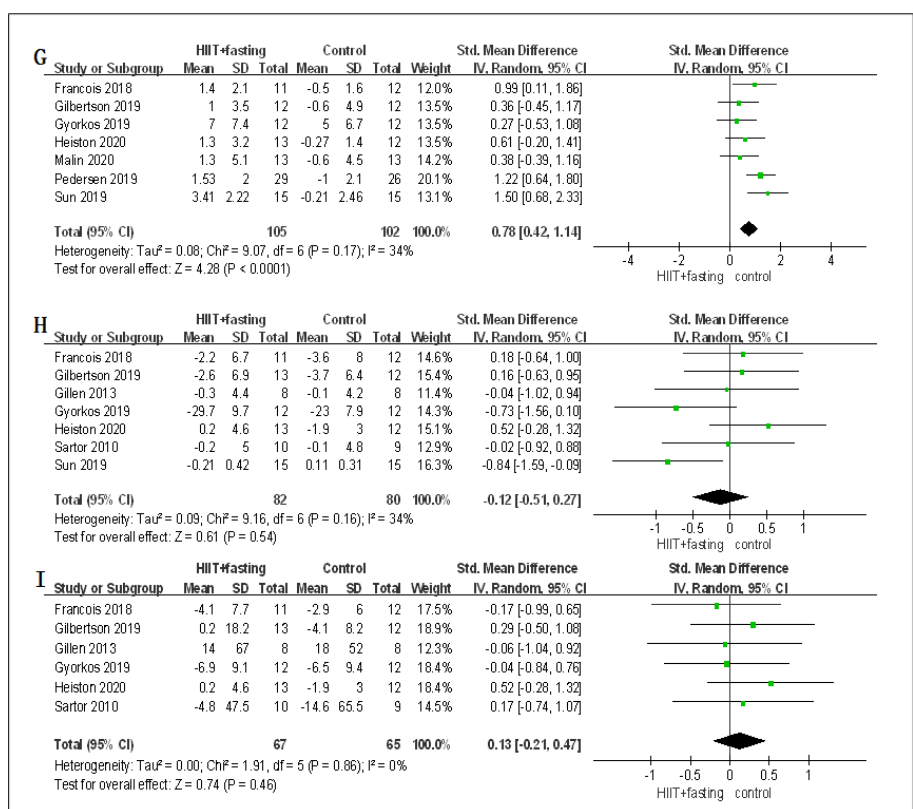
Figure 4. Forest plot for the body composition. ( A ) Forest plot for the body mass (BM); ( B ) Forest plot for the body mass index (BMI); ( C ) Forest plot for the waist circumference (WC); ( D ) Forest plot for the percent fat mass (PFM); ( E ) Forest plot for the fat mass (FM); ( F ) Forest plot for the fat-free mass (FFM); ( G ) Forest plot for changes in VO 2peak .; ( H ) Forest plot for changes in fasting plasma glucose (FPG); ( I ) Forest plot for changes in fasting plasma insulin (FPI). The size of each small green box represents the relative weight of the studies conducted in the meta-analysis. The black diamond represents the results of the meta-analysis combining the individual studies.